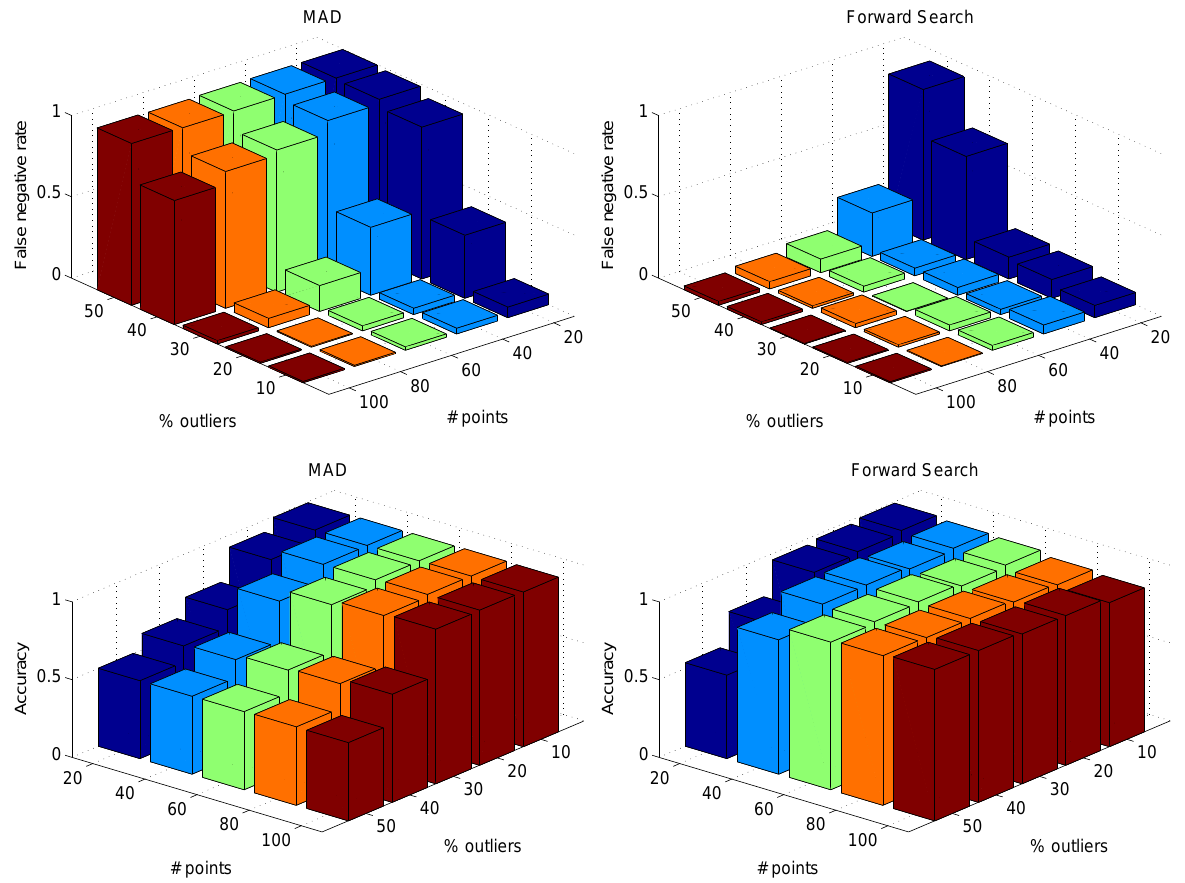
Figure 6: Top row: false negative rate vs percentage of outliers and number of points for MAD (left) and FS (right). Bottom row: accuracy vs percentage of outliers and number of points for MAD (left) and FS (right). Gaussian noise has σ = 2 . 0 . of true positives , i.e., outliers that are correctly detected and d be the number of true negatives , i.e., inliers that are correctly